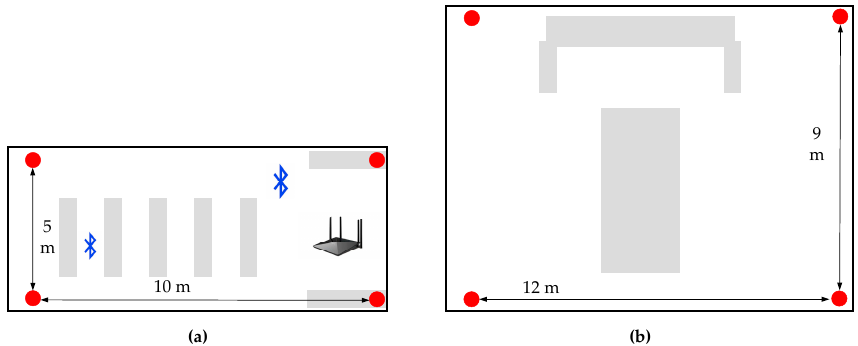
Figure 8. The test setup: ( a ) a classroom (scenario #1); ( b ) an office room (scenario #2). The red point is the location station; the gray bars denote desks and cupboards.